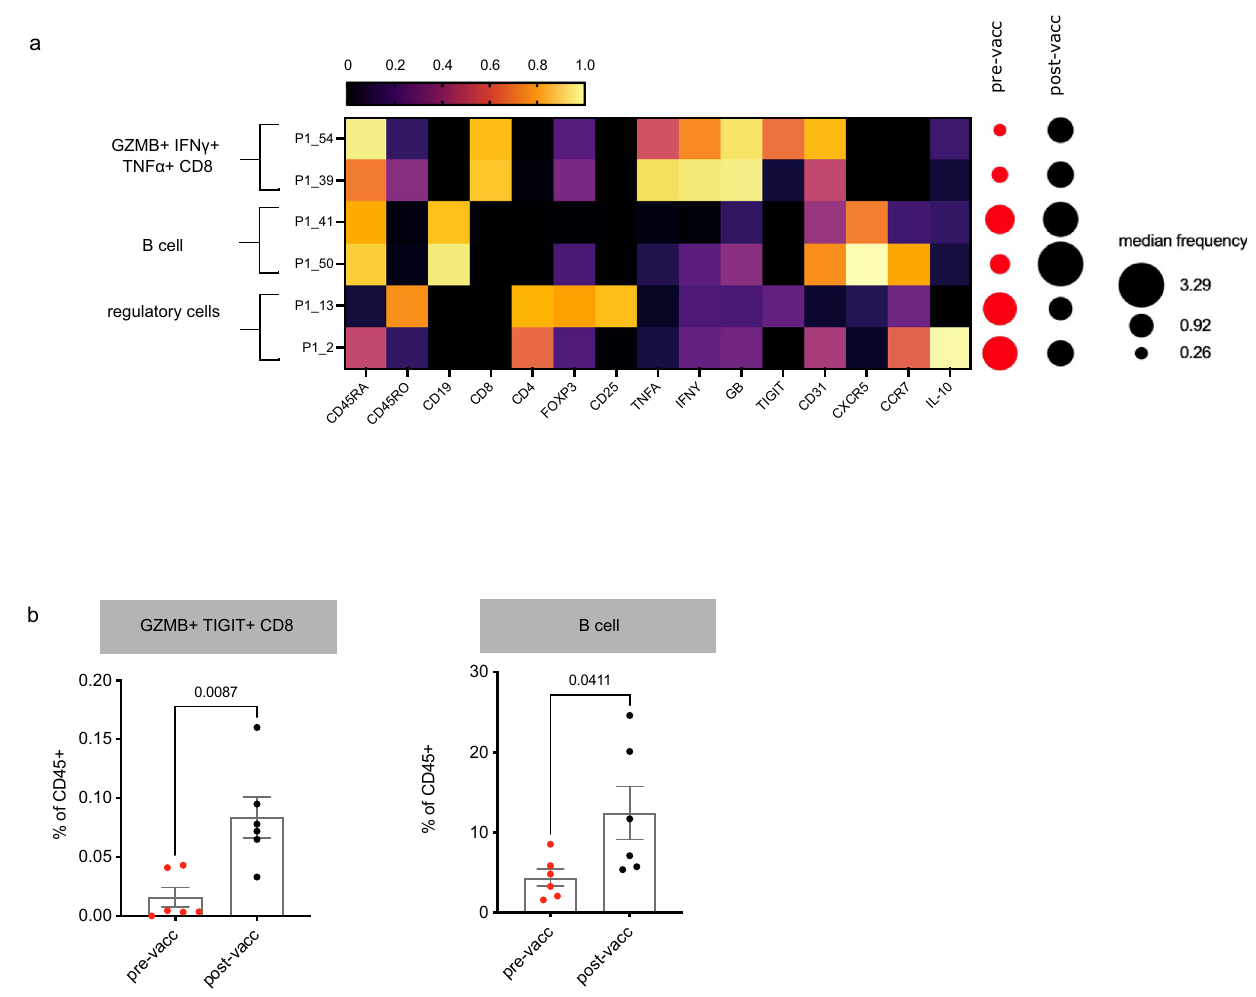
Fig. 4| StablediseasepatientsshowincreasedcytotoxicCD8sand Bcellspost- vaccination. a Mass cytometry data were clustered by FlowSOM and analysed for clusters that differed pre and post-vaccination in patients with stable disease as de fi ned by RECIST v.1.1. The phenotypes of these clusters are summarised in the heatmaps of marker expression. The median frequency of each cluster was repre- sented by the size of the dots. b Manual gating validation of selected subsets in